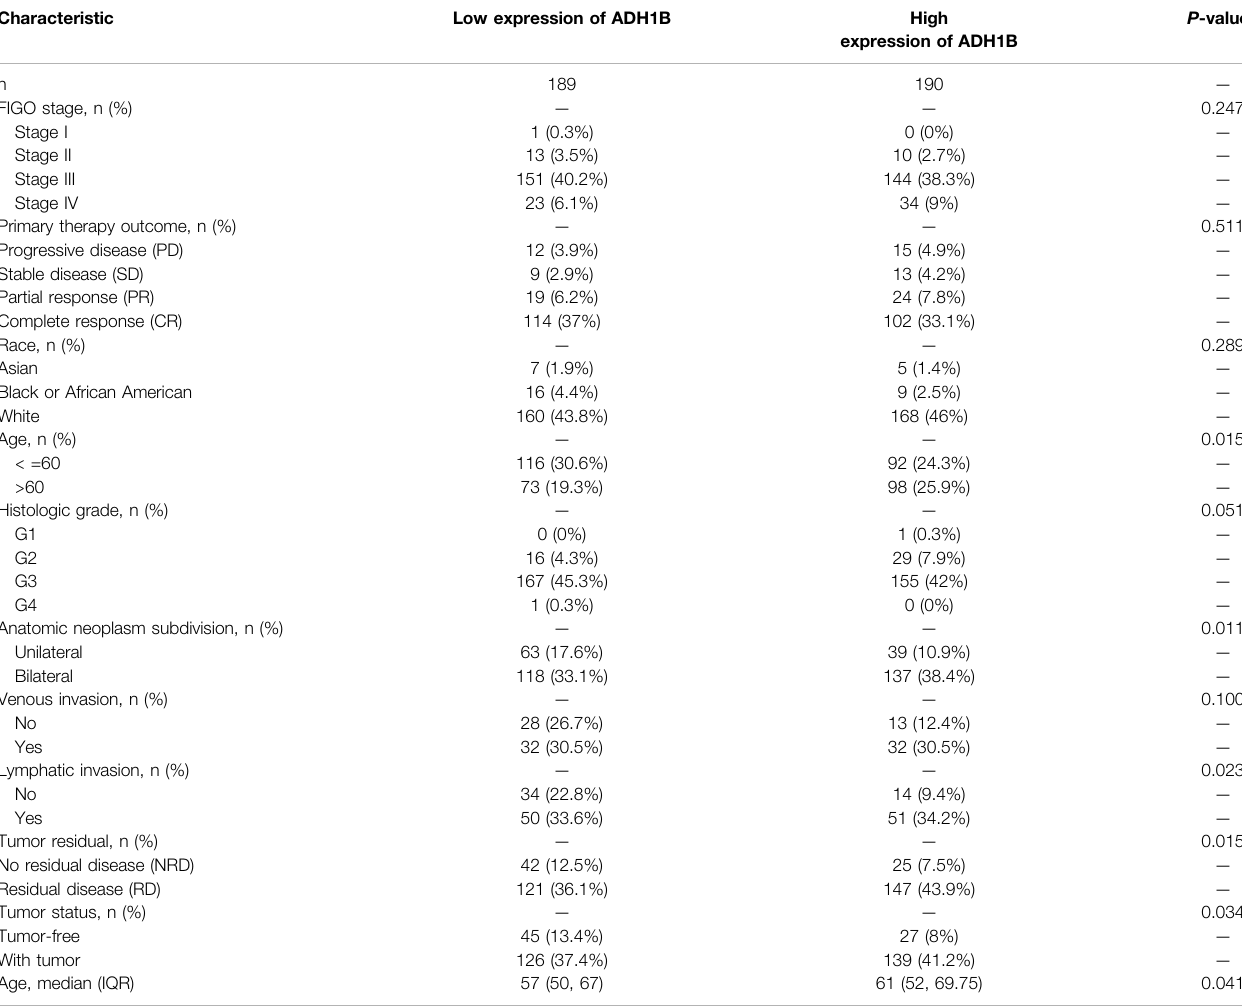
TABLE 1 | The demographic parameters for ovarian cancer patients from the TCGA database based on the ADH1B levels.